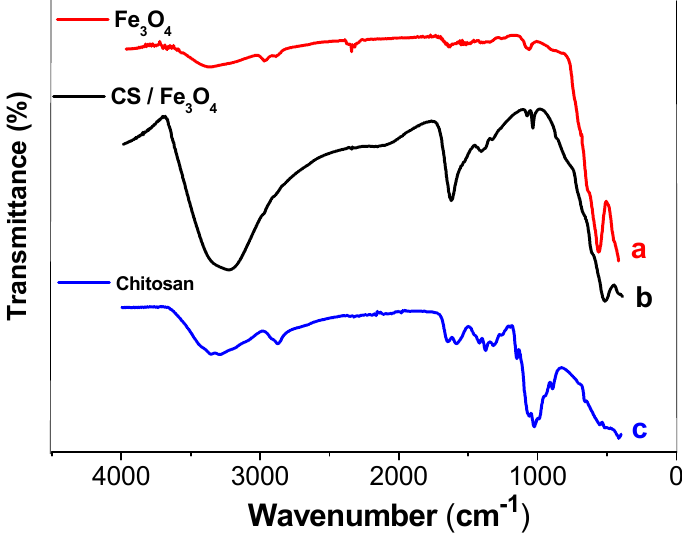
Figure 2. FTIR spectra of (a) Fe 3 O 4 , (b) chitosan, and (c) CS/Fe 3 O 4 .